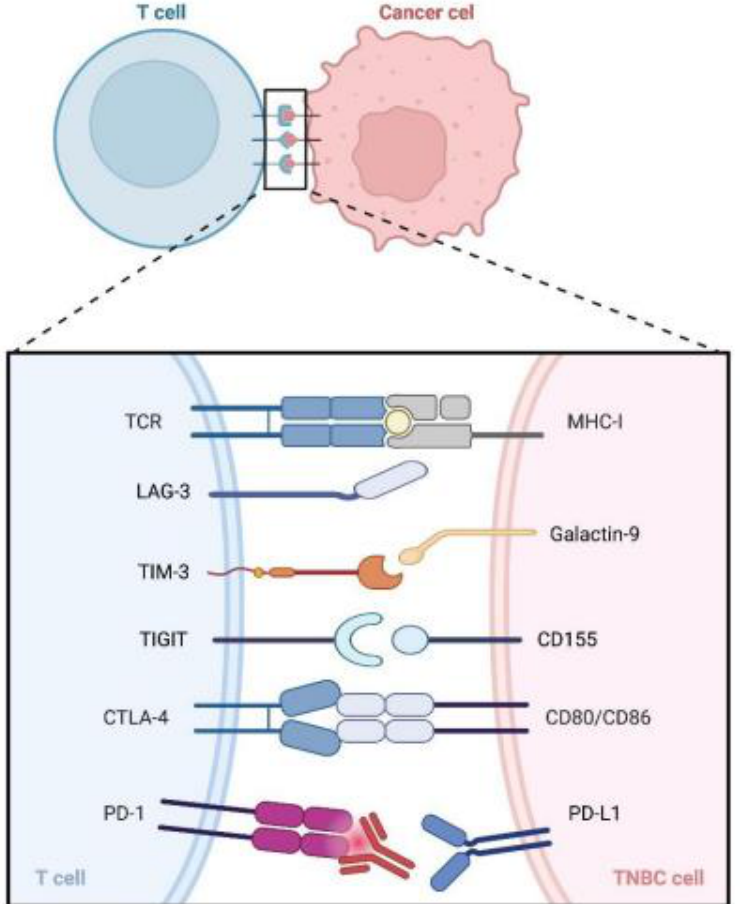
Figure 5. Inhibitory immune checkpoints for TNBC. TNBC cells express immune checkpoint ligands, which mediate resistance to PD-1/PD-L1 inhibitors by inhibiting T cell function. After the PD-1/PD-L1 signaling pathway is blocked by inhibitors, other immune checkpoints, such as CTLA-4, TIGIT, TIM-3 and LAG-3, are compensated upregulated. Abbreviations: PD-1, programmed cell death protein 1; PD-L1, programmed cell death 1 ligand 1; CTLA-4, cytotoxic T-lymphocyte-associated protein 4; TIGIT, T cell immunoglobulin and ITIM domain; TIM-3, T cell immunoglobulin domain and mucin domain-3; LAG-3, lymphocyte activation gene-3; TCR, T cell receptor; MHC-II, major histocompatibility complex class II; TNBC, triple negative breast cancer.